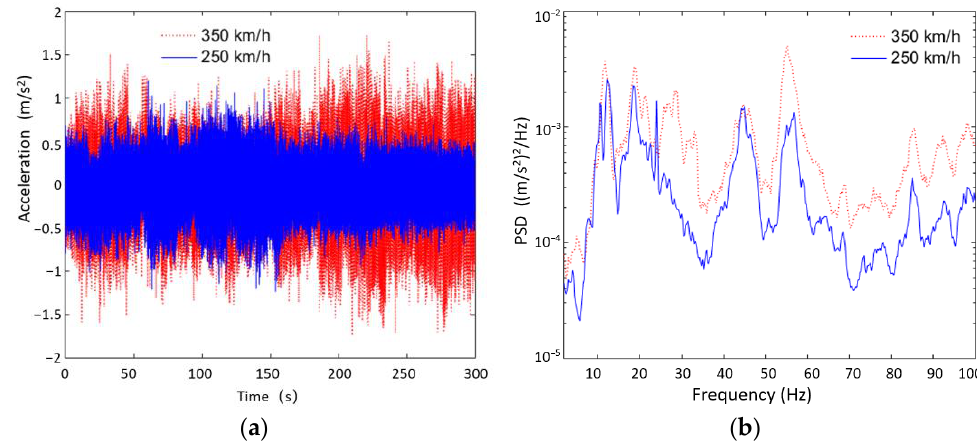
Figure 2. Z -direction acceleration measured at the carriage floor . ( a ) Signals in time domain; ( b ) power spectral density.